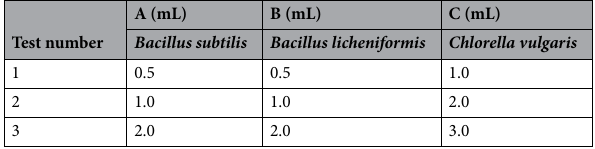
Table 2. The level and value range of different factors in orthogonal experimental